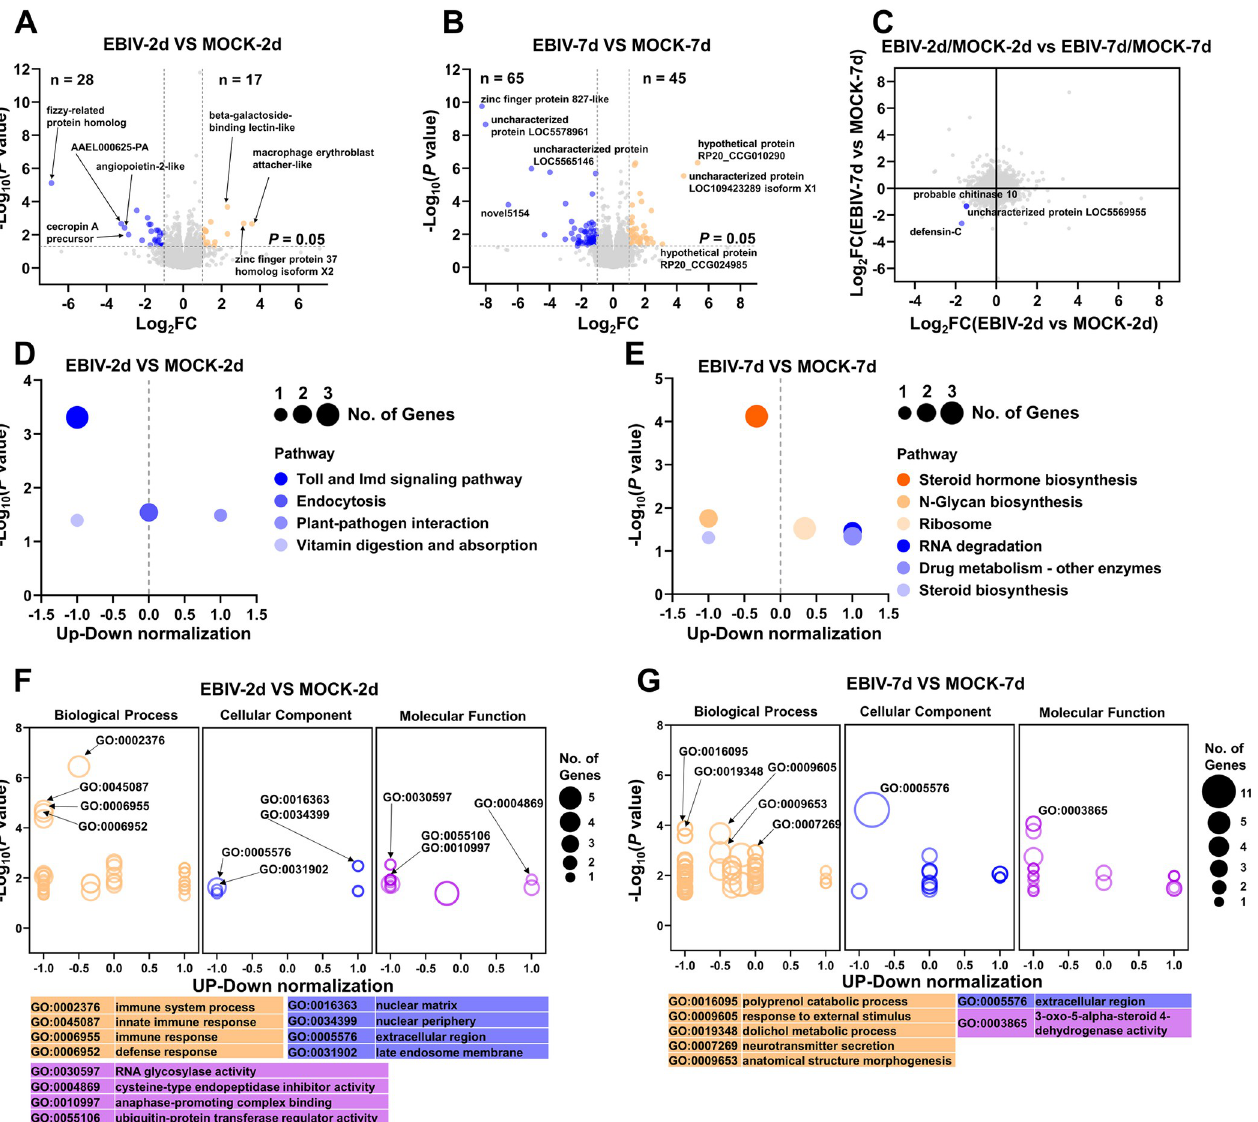
Fig 4. EBIV affects specific gene expression patterns in intrathoracically infected mosquitoes. Significantly upregulated (orange) and downregulated (blue) genes in EBIV-infected compared with mock-infected mosquitoes at 2 dpi (A) and 7 dpi (B). (C) Genes displaying differential responses in EBIV-infected mosquitoes at 2 and 7 dpi were determined via a scatter plot of expression changes. KEGG pathway analyses of DEGs at 2 dpi and 7 dpi are presented in (D) and (E), respectively. Enriched GO categories associated with DEGs at 2 dpi and 7 dpi are shown in (F) and (G), respectively.